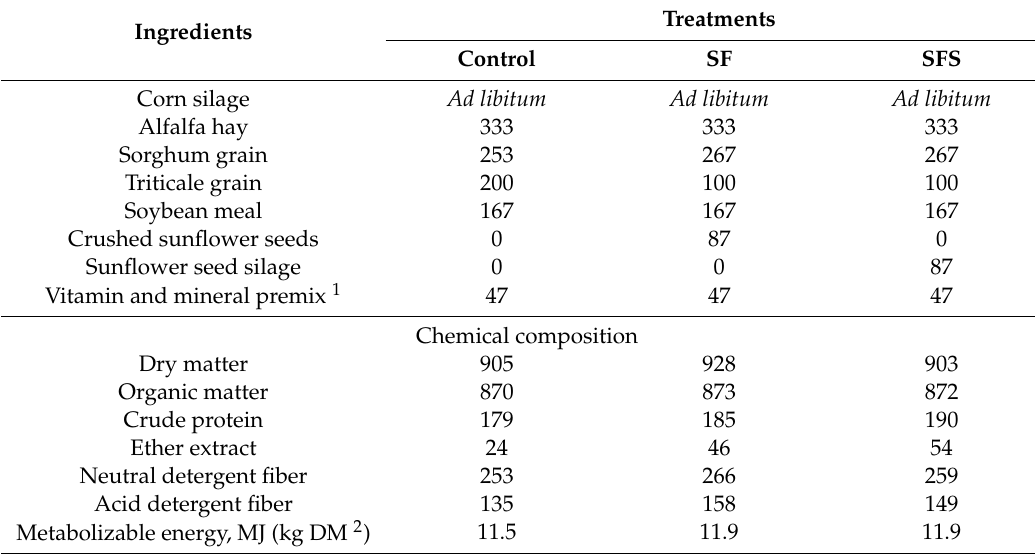
Table 2. Inclusion of ingredients (g / kg DM) and chemical composition (g / kg DM) of control, sunflower seeds (SF) and sunflower seeds silage (SFS)